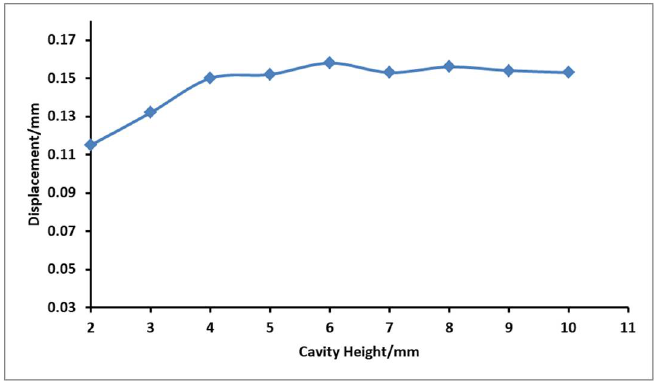
Figure 10. Relationship between different cavity height and flexible film displacement.